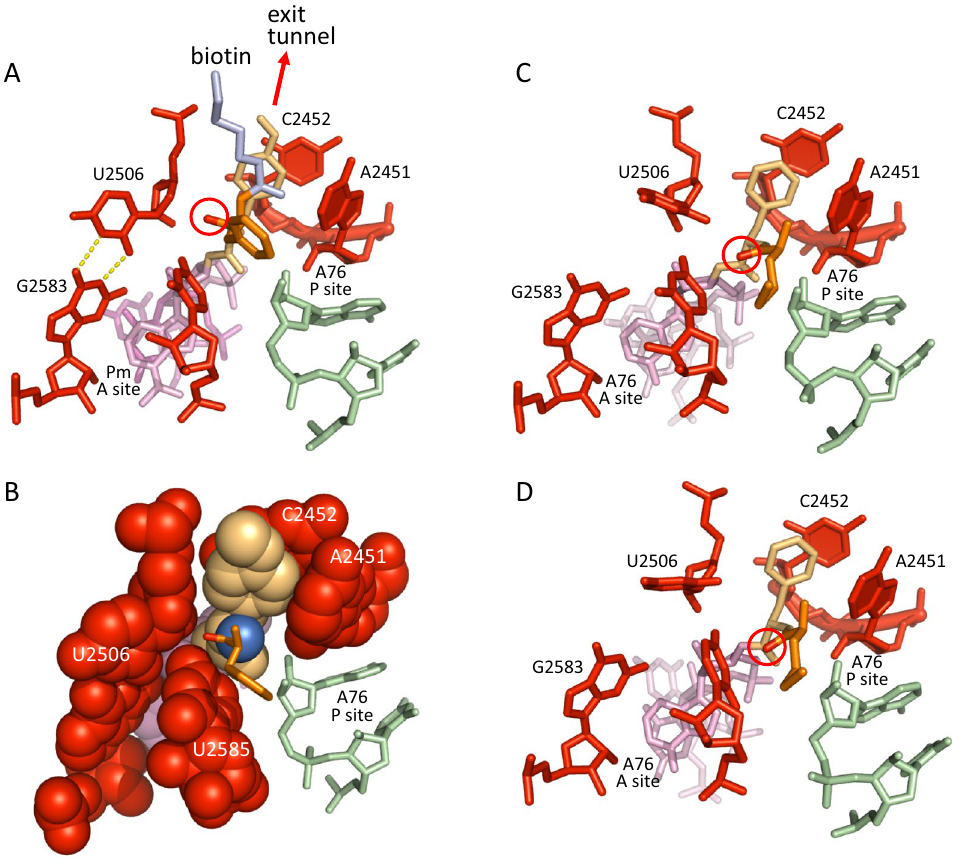
Figure 2. Decompaction of the PTC upon peptide bond formation. ( A ) Crystal structure of a CC-puromycin- dipeptide anchored in the cavity of the PTC by a biotin (pdb 1kqs) 13 , representing the situation just after peptide bond formation, when the 3 ʹ end of the A site tRNA has not yet moved to the P site (res.: 3.1 Å). The biotin linker (shown in blue grey) keeps the dipeptide in a stretched configuration oriented towards the exit tunnel (red arrow). ( B ) Same structure as in A, with van der Waal representation (the biotin linker is not shown). ( C ) Crystal structure of a dipeptidyl-tRNA bound to the A site of the ribosome (pdb 1vy5) (res.: 2.55 Å) 18 . ( D ) Cryo-EM structure of a dipeptidyl-tRNA bound to the A site of the ribosome (pdb 6wde) (res.: 3.0 Å) 19 . The carbonyl oxygens of the peptide bonds are circled in ( A,C,D